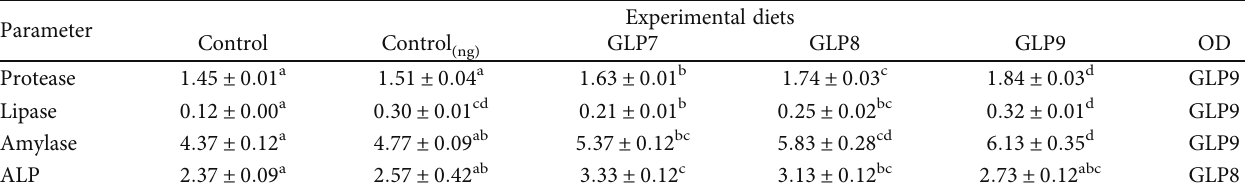
Table 6: Protease, lipase, amylase, and ALP (alkaline phosphatase) (U mg -1 protein) of narrow-clawed cray fi sh fed with di ff erent experimental diets after 97